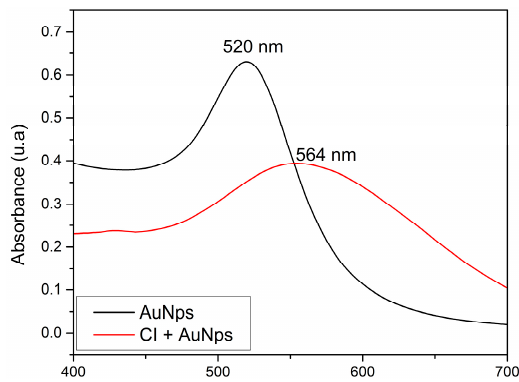
Figure 1. UV-visible absorption spectra of citrate-stabilized AuNPs (recorded in transmission mode), and of AuNPs adhered to the crystal surface of the IC (recorded in diffuse reflectance mode).